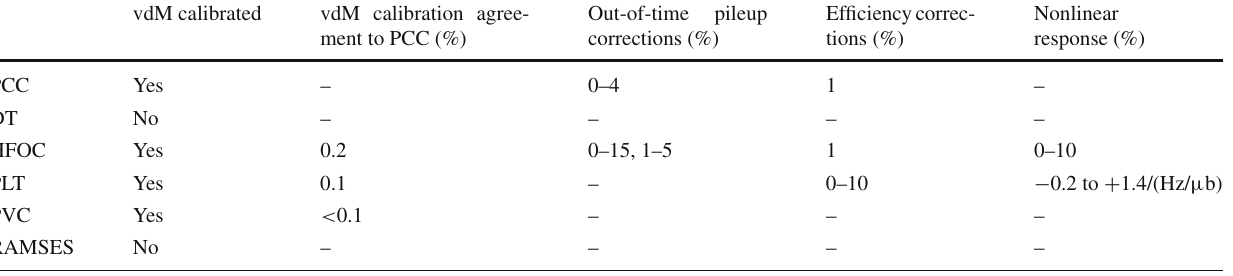
agreement of the luminometers in terms of A eff relative to PCC during fill 4954 are given, respectively. The DT luminosity is also corrected for a very small additional muon rate from beam halo and cosmic sources, which is treated as a constant per fill